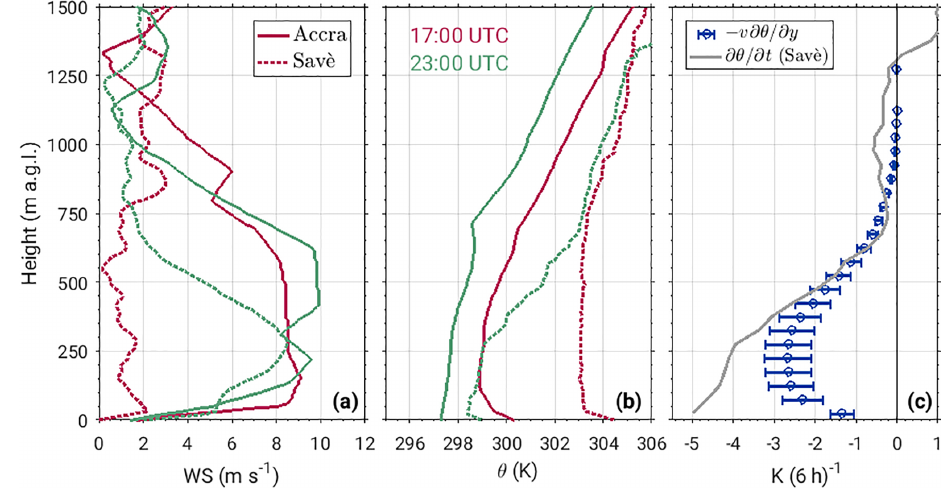
Figure 9. Comparison of vertical profiles of horizontal wind speed (a) and potential temperature (b) in Accra (solid line) and Savè (dashed line) at 17:00 (red) and 23:00UTC (green). (c) The mean horizontal advection estimated between the coast and Savè for different front locations (50, 75, 100, and 125km from the coast) during the 6h period (17:00–23:00UTC) using radiosonde measurements in Accra and Savè (blue), while the error bars show 1 standard deviation. The potential temperature change observed at Savè during this period is shown in